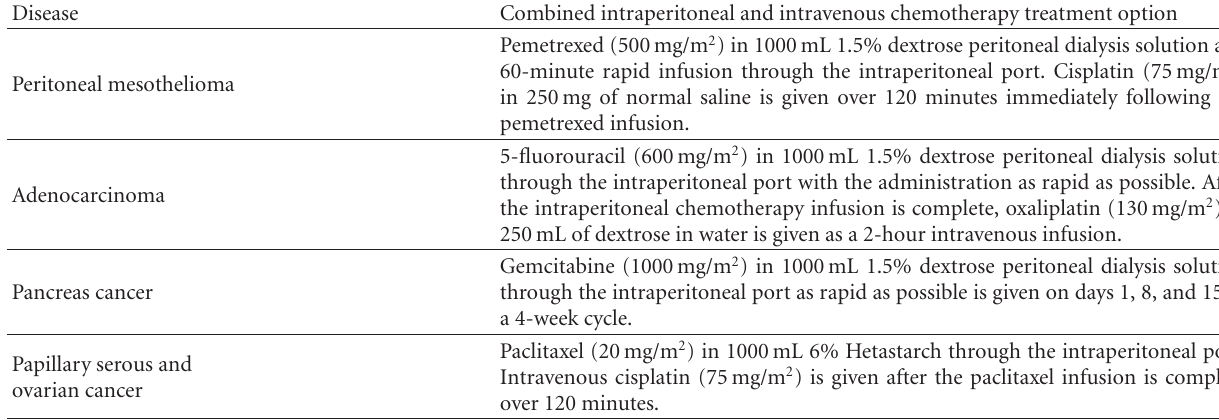
Table 2: Four di ff erent combined intraperitoneal and intravenous chemotherapy (bidirectional) treatment options.